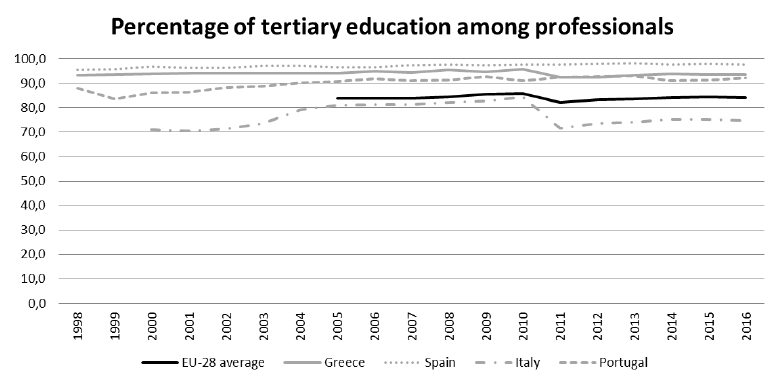
Figure 7: Percentage of professionals with tertiary education among professionals 1998- 2016